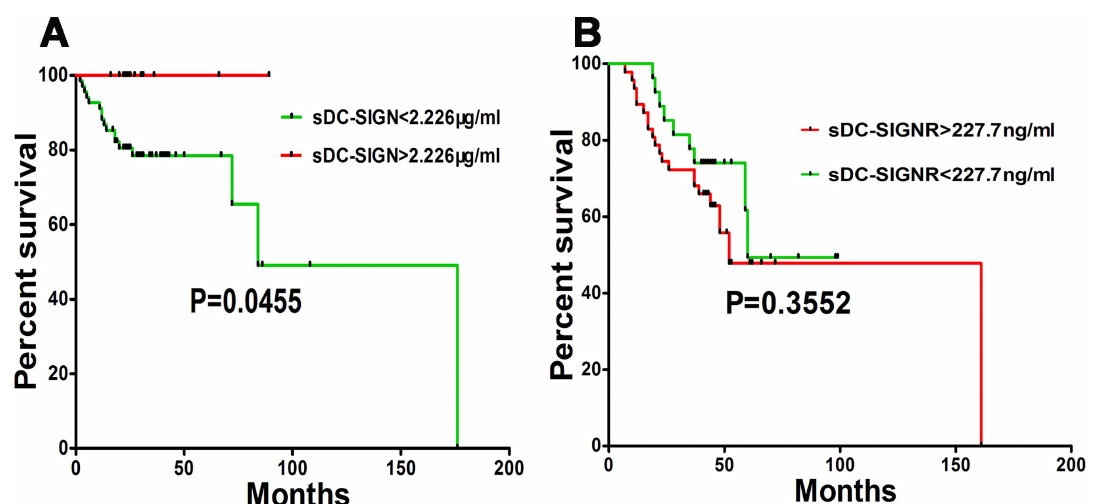
Fig. 3. The prognostic significances of sDC-SIGN and sDC-SIGNR in cancer patients. The cut-off values of these markers were obtained from the above analysis of Youden index. A : There were significant differences in survival time between the patients (the level of sDC-SIGN . 2.226 m g/ml) and the other patients (the level of sDC-SIGN . 2.226 m g/ml) (P , 0.05). B : the survival time of the patients (sDC-SIGNR , 227.7) was not significantly different with that of the other patients (sDC-SIGNR . 227.7) (P .